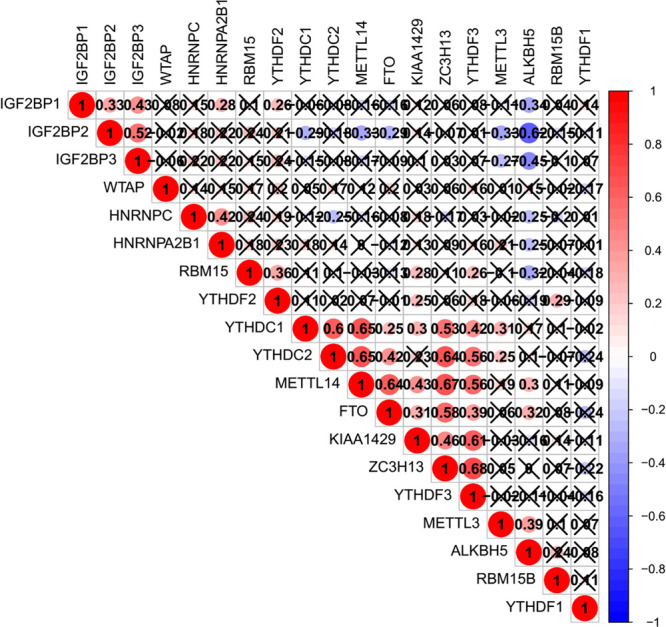
Co-expression of m6A regulator genes.